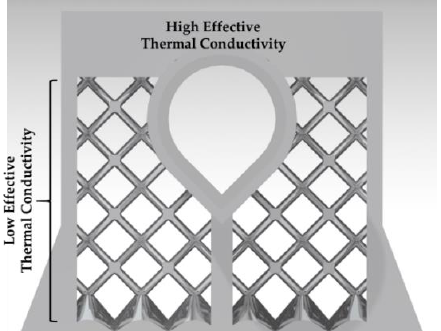
Figure 8 . Effect of lattice structures on thermal conductivity of a hot stamping die .